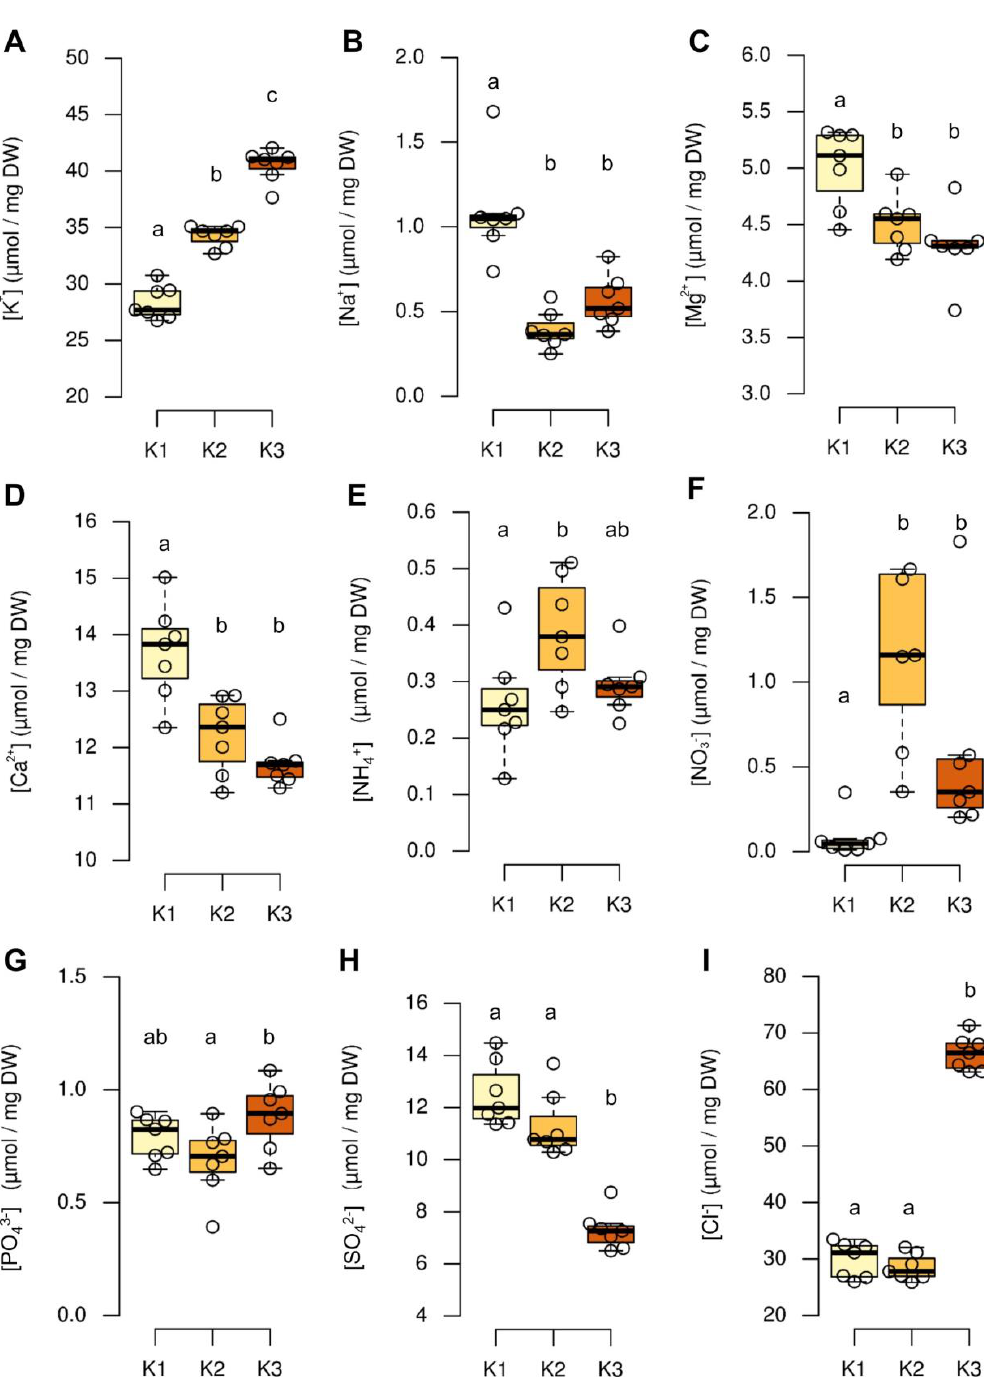
Figure 2. Effect of different soil K levels on nutrient concentrations in shoots of P. major plants. ( A ) Potassium content, ( B ) sodium content, ( C ) ammonium content, ( D ) magnesium content, ( E ) calcium content, ( F ) nitrate content, ( G ) phosphate content, ( H ) sulfate content, and ( I ) chloride content. Boxplots show distribution of n = 7 replicates. Center lines show the medians; box limits indicate the 25th and 75th percentiles. Different letters above boxes indicate significant differences between the K conditions, according to one-way ANOVA with post-hoc Tukey HSD test ( p = 0.05).